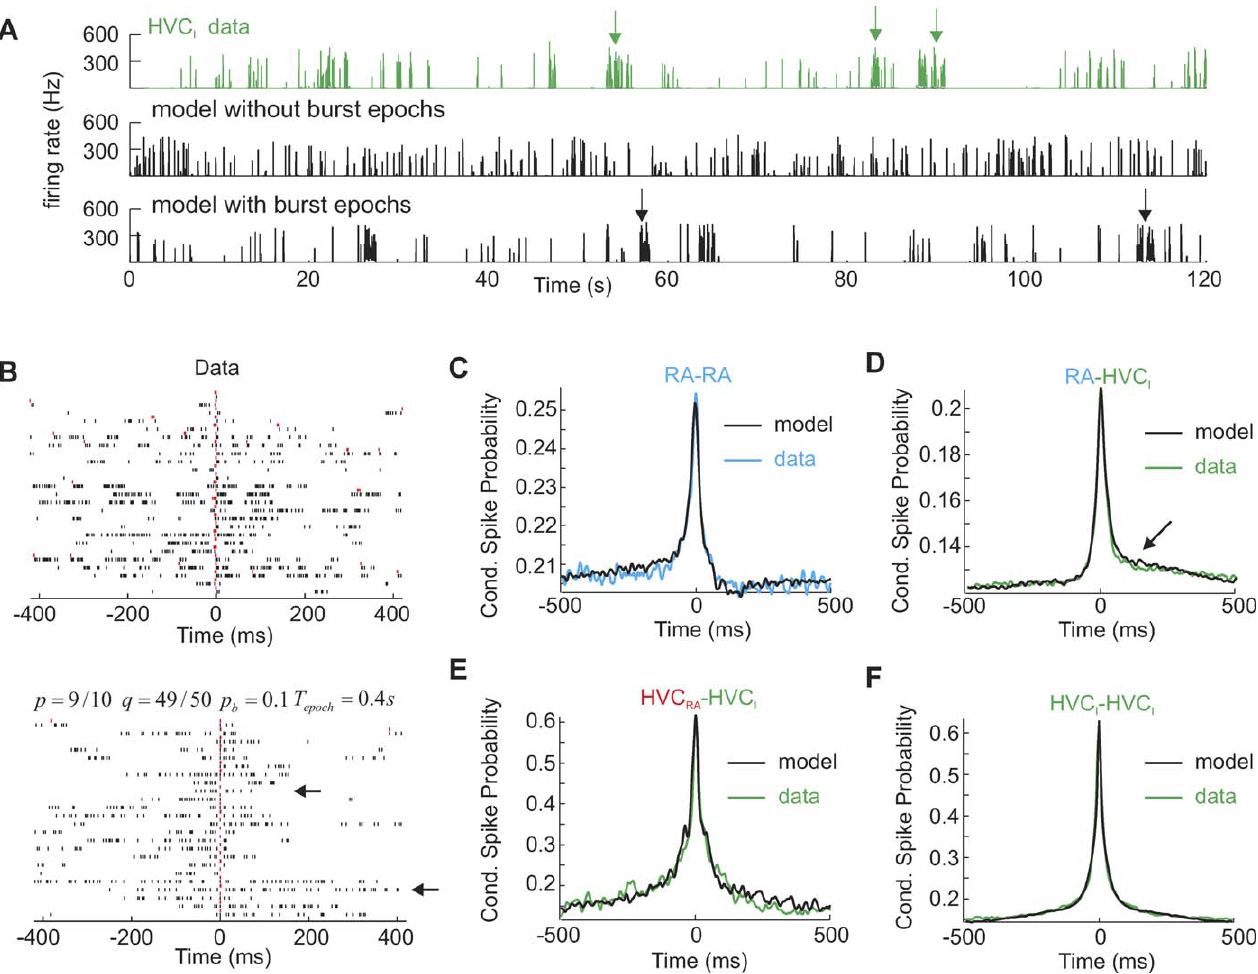
Figure 5. Burst Epochs and Pairwise Correlations (A) Instantaneous firing rates of a recorded HVC I neuron (top), a simulated HVC I neuron without burst epochs (middle), and a simulated HVC I neuron with burst epochs (bottom). Burst epochs are indicated by arrows. (B) A sample raster plot of a simultaneously recorded HVC RA –HVC I pair (top) and a comparable plot from model simulations (bottom). The inclusion of burst epochs gives rise to rows with very sparse HVC I bursting (top arrow) and rows with dense HVC I bursting (bottom arrow), as is seen in real data. (C–F) Average CSP functions in different neuron types. The functions are plotted in reference to a spike in the first pair, i.e., with respect to RA spikes in (D) and with respect to HVC RA spikes in (E). (C) RA–RA neuron pairs (from n ¼ 29 recorded pairs). p ¼ 6/7, and q ¼ 39/40. (D) RA–HVC I pairs ( n ¼ 50 pairs). The arrow indicates an asymmetry that is reproduced by the model. p ¼ 9/11, and q ¼ 49/50. (E) HVC RA –HVC I ( n ¼ 26). p ¼ 7/8, and q ¼ 59/60. (F) HVC I –HVC I pairs ( n ¼ 19). HVC I neurons randomly link to 56 of the 100 HVC RA groups. p ¼ 7/8, and q ¼